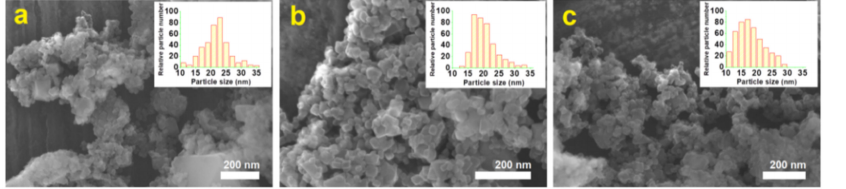
Figure 5. FE-SEM micrographs recorded on ( a ) MgCr 2 O 4 _HMTA, ( b ) MgCr 2 O 4 _FS, and ( c ) MgCr 2 O 4 _TA.